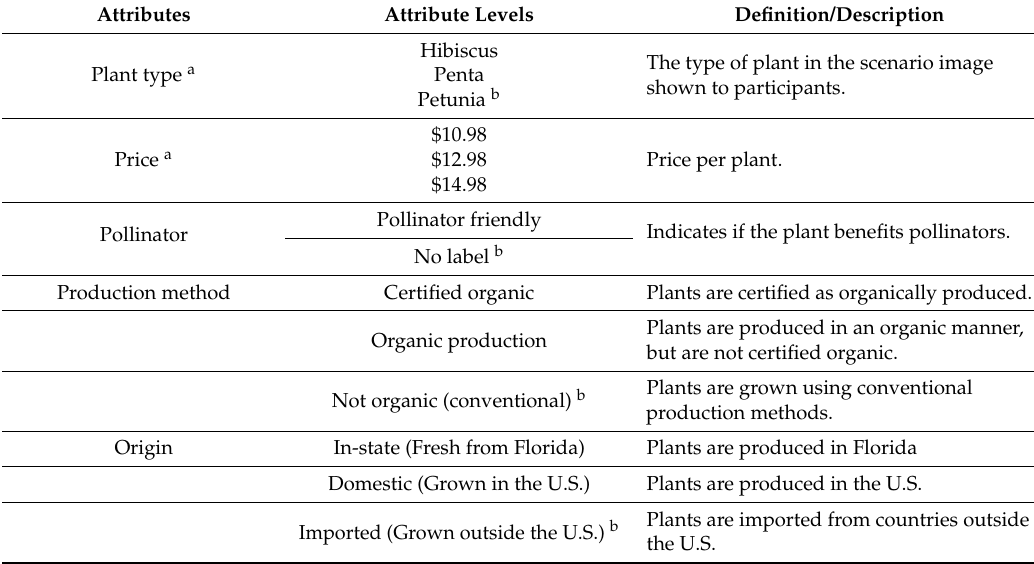
Table 2. Attributes and attribute